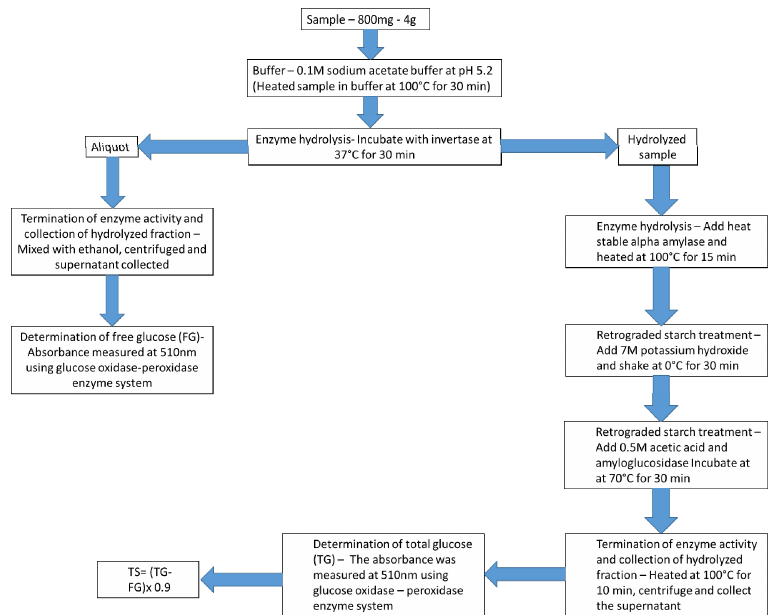
Figure 6. Instantaneous procedure for the determination of total starch (TS) as per Englyst et al. [48]. The freely available glucose (FG) and total glucose (TG) matters were defined by quantifying the total starch content of the sample. Copyright was obtained from Perera et al. [37].